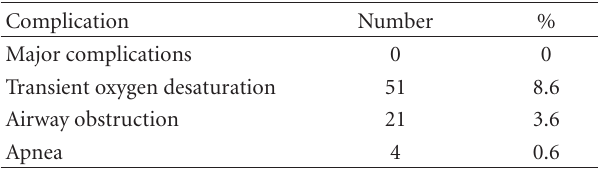
Table 6: Complications observed (all minor).